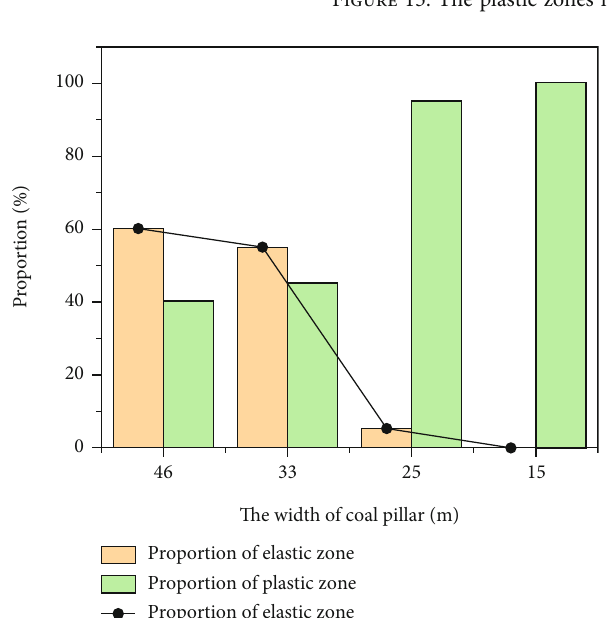
Figure 15: The plastic zones in coal pillars with di ff erent widths.